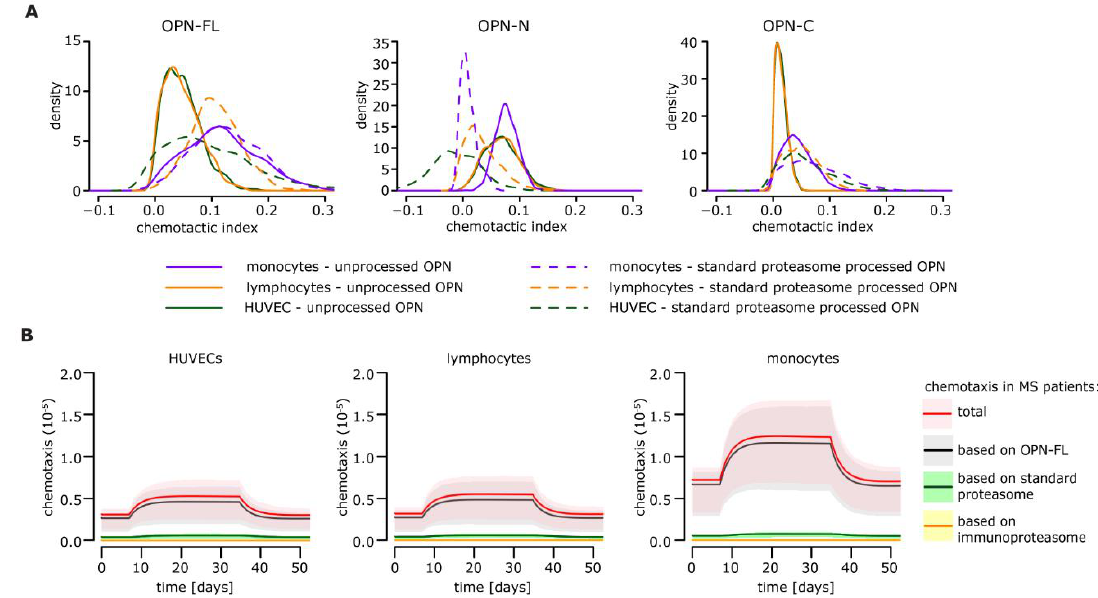
Figure 6. Extracellular OPN and proteasome dynamics and related chemotaxis for HUVECs, lymphocytes, and monocytes. ( A ) Chemotactic indices of OPNs (OPN-FL, OPN-N, and OPN-C) as well as their derived fragments generated by standard proteasomes for HUVECs, lymphocytes, and monocytes. ( B ) Chemotaxis levels over the course of the disease for MS patients based on cell migration experiments [25] performed with HUVECs (left), lymphocytes (middle), or monocytes (right). Simulations are based assuming that only standard proteasomes (absence of immunoproteasome) and only OPN-FL (absence of thrombin) are present in the system.